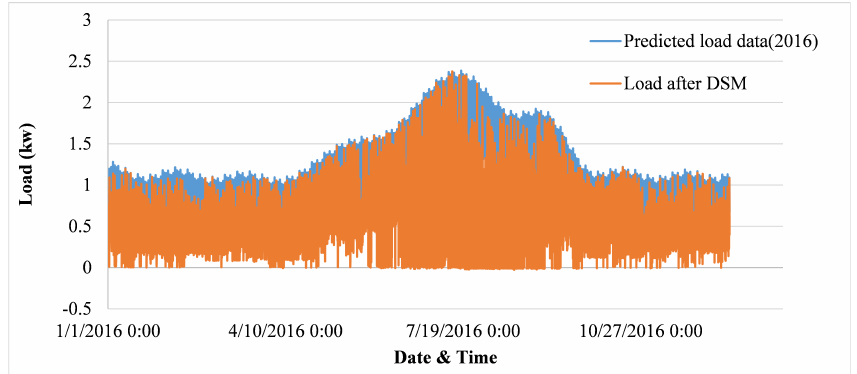
Figure 11. Demand side management on the predicted data.